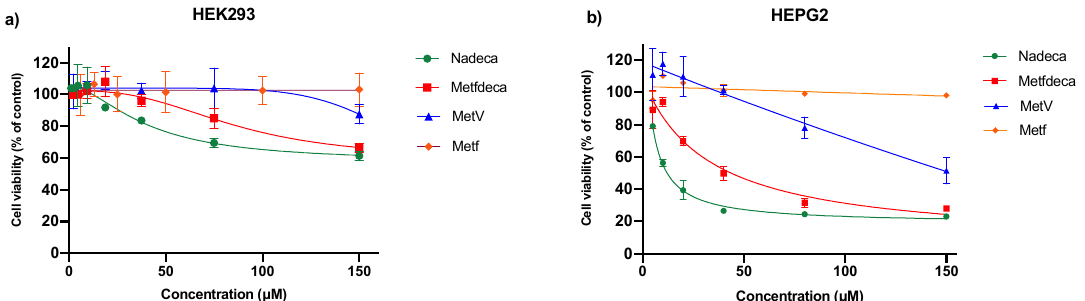
Figure 4. Cell viability assay at different vanadium compounds concentrations after treatment for 24 h ( a ) HEK293 and ( b ) HEPG2 cells. The cell viability of each treatment group was compared with the corresponding untreated control, which was normalized to 100% of cell viability. Error bars represent the standard deviation for triplicate runs ( n = 3).